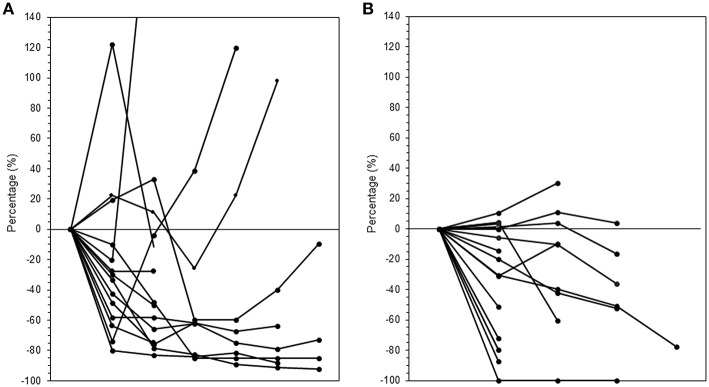
Changes in tumor volumes over time after radiation in the (A) RT-alone and (B) ICI+RT groups. ICI, immune checkpoint inhibitors; RT, radiotherapy; ICI+RT, pembrolizumab combined with RT.